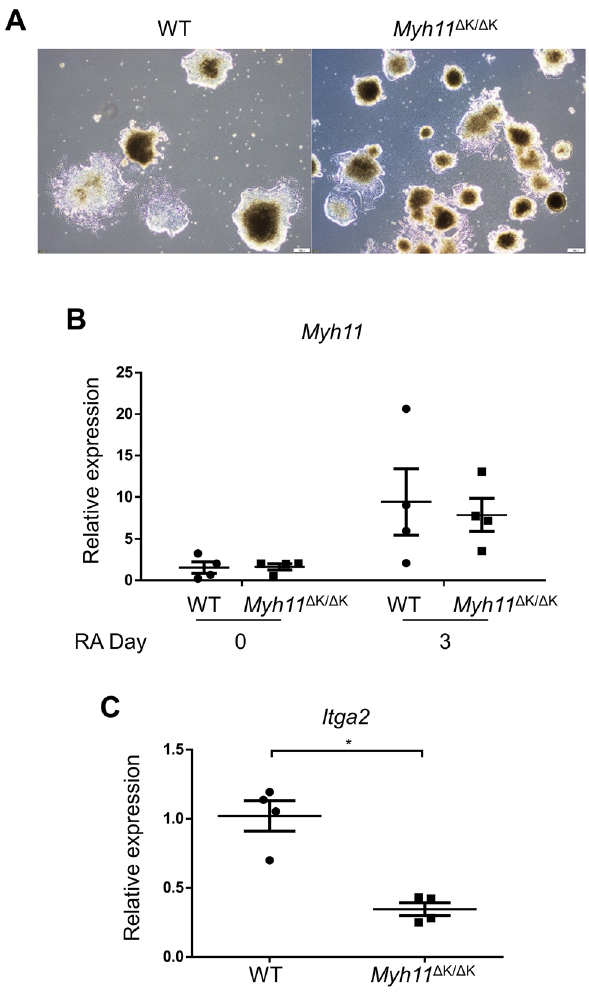
contrast images of WT and Myh11 ∆K/∆K iPSCs at day 5 of differentiation by retinoic acid (scale bar = 200 µm). (B) RT-qPCR analysis of Myh11 mRNA isolated iPSCs at days 0 and 3 of treatment with retinoic acid. Gene expression levels were normalised to18s rRNA (n = 4, day 0: p = 0.9714; day3: p > 0.9999). Mann–Whitney U test. RA = retinoic acid. (C) RT-qPCR analysis of Itga2 mRNA isolated iPSCs at day 3 of differentiation by retinoic acid. Gene expression levels were normalised to18s rRNA. *p < 0.05, Mann–Whitney U